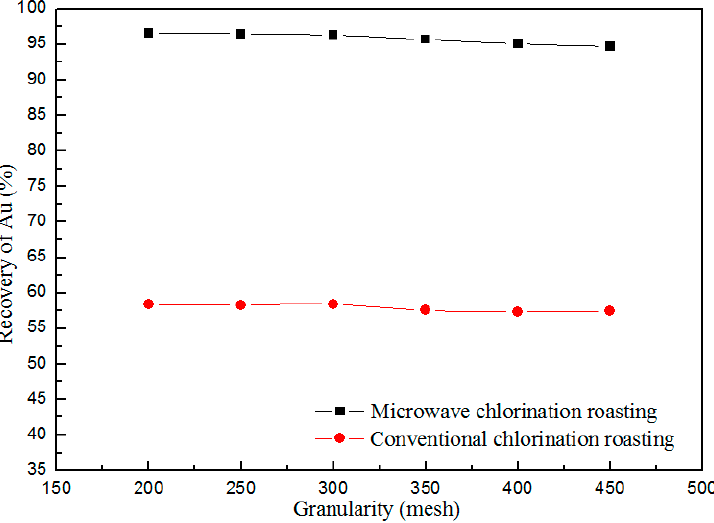
Figure 7. Effect of mineral (cyanidation tailing (CT)) particle size on the recovery of Au.